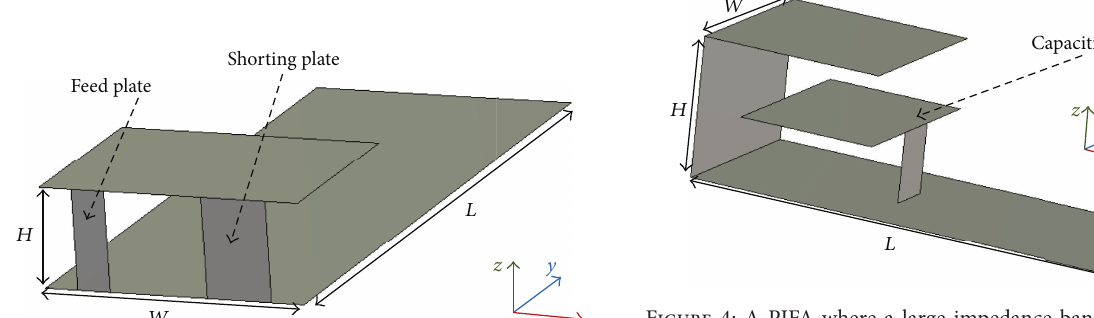
Figure 4: A PIFA where a large impedance bandwidth has been obtained by using a capacitive feeding [14].